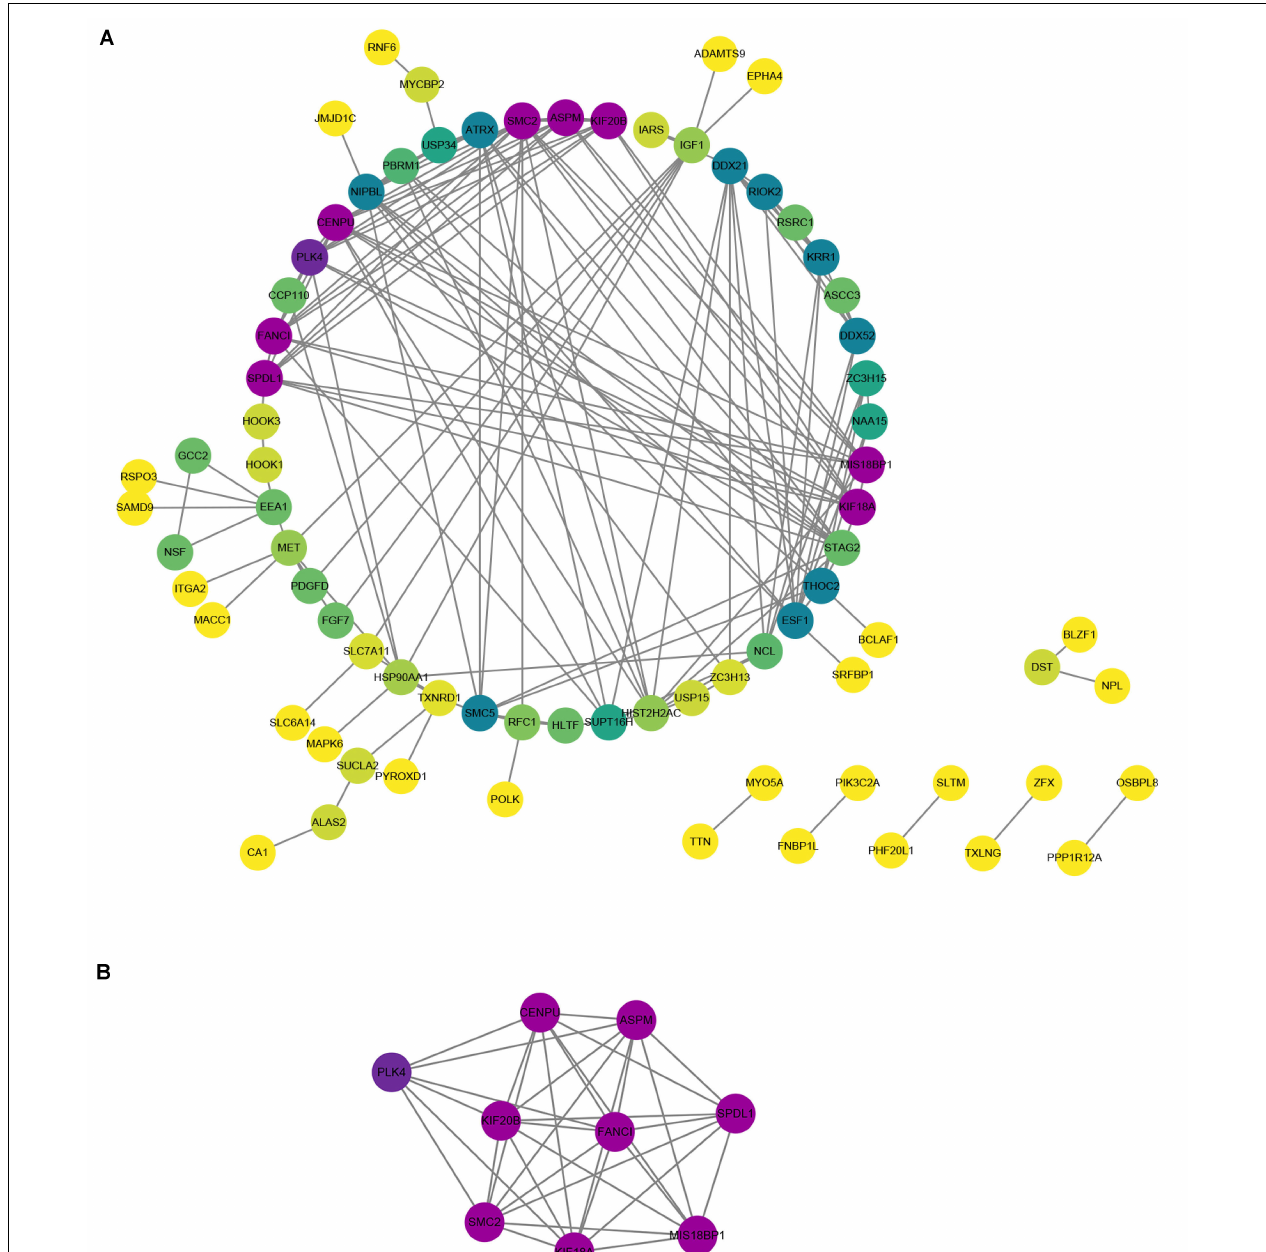
FIGURE 6 | Protein–protein interaction (PPI) network and hub genes in PAH. (A) The PPI network of DEGs contained 77 nodes and 155 edges. Purple was the most significant, followed by green, and yellow was the least significant. In the same color, the darker the color, the more significant it was. (B) The most significant module was obtained from PPI network of